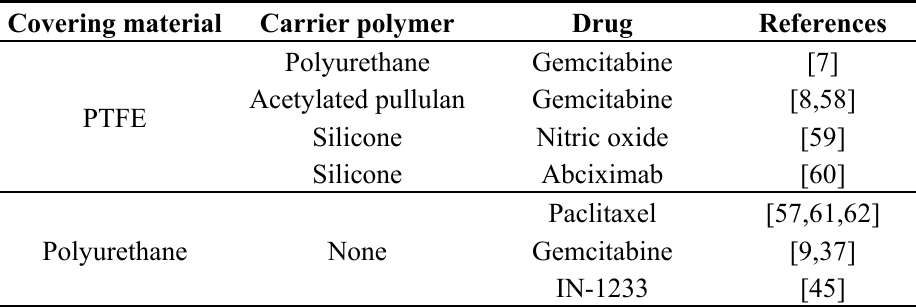
Table 2. Drug delivery via covered non-vascular